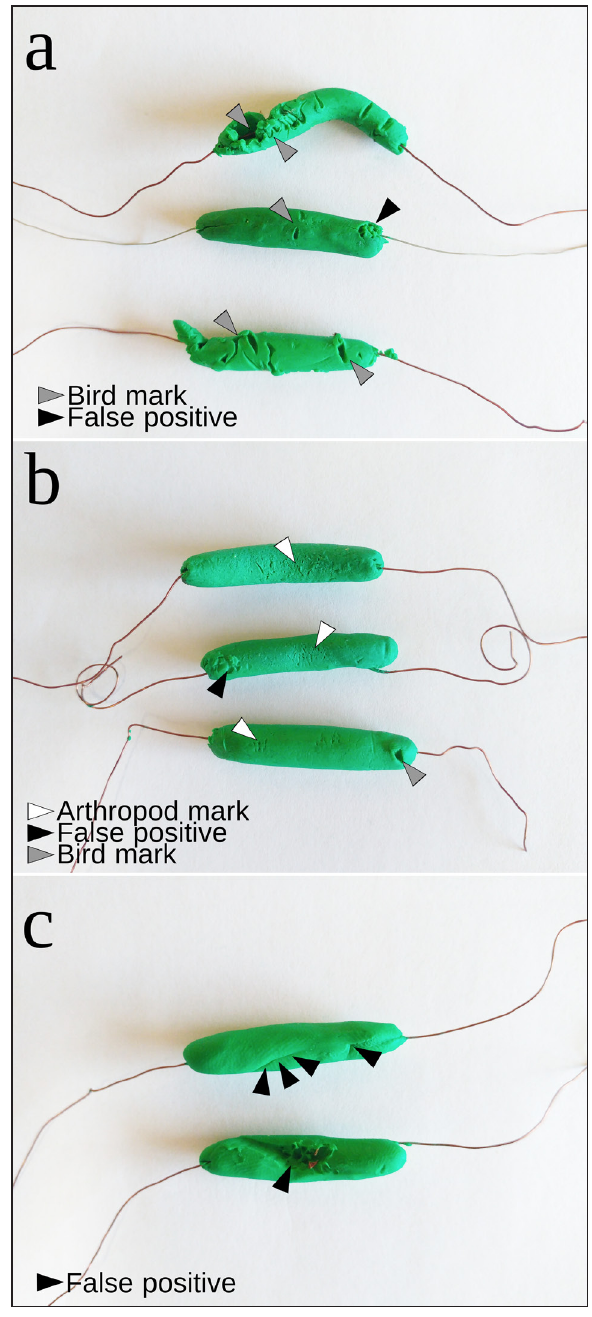
Figure 4: Examples of real and false-positive observa- tions of predation. (a) Grey arrows point to typical bird predation marks. The black arrow points toward marks made by the wire when attaching the caterpillar on the branch and taking it off. (b) White and grey arrows indi- cate marks made by arthropod mandibles and bird beaks, respectively. (c) Black arrows indicate typical marks erro- neously counted as predation marks by school children. The scar-like mark on the top caterpillar was made when rolling the caterpillar onto the wire. Deep marks on the bottom caterpillar are imprints of branches and